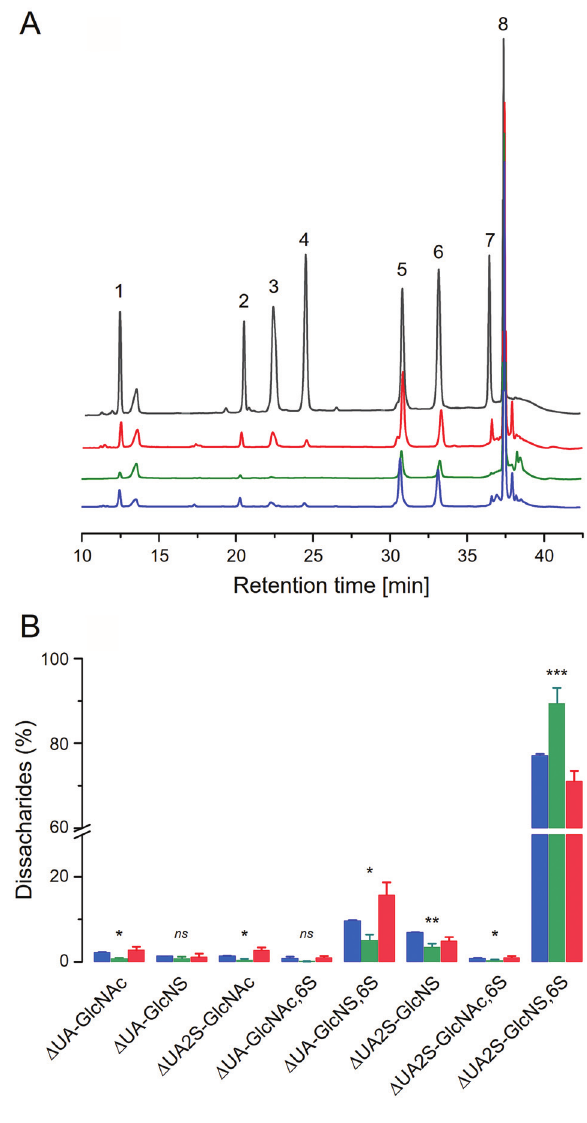
Fig. 5 SAX-HPLC disaccharide analyses reveal differences among heparins obtained from different sources. (A) Chromatograms of the disaccharides formedbydigestionofHOI,HBLandHPI(inblue,greenandred,respectively, in all panels) with a mixture of heparinases I, II and III and of a mixture of heparin disaccharides standard (in black): 1) Δ UA-Glc N Ac; 2) Δ UA-Glc N S;3) Δ UA2S-Glc N Ac; 4) Δ UA-Glc N Ac6S, 5) Δ UA-Glc N S6S; 6) Δ UA2S-Glc N S; 7) Δ UA2S-Glc N Ac6S; and 8) Δ UA2S-Glc N S6S. (B) Quanti fi cations of the anal- yses of three chromatograms of each heparin: (cid:1) HBL 6¼ HPI; (cid:1)(cid:1) HOI 6¼ HBL; (cid:1)(cid:1)(cid:1) HOI 6¼ HBL 6¼ HPI; and ns ¼ non-signi fi cant differences (ANOVA with Bonferroni post hoc